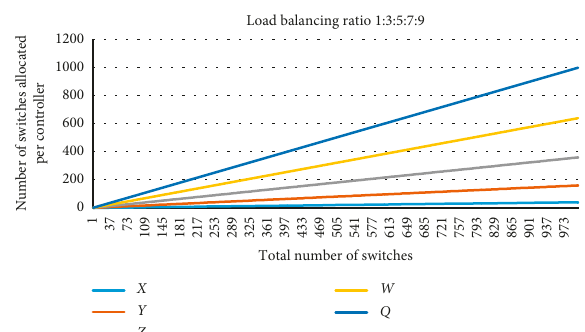
Figure 13: Load balancing for five slave controllers with ratios 1: 3: 5: 7: 9.